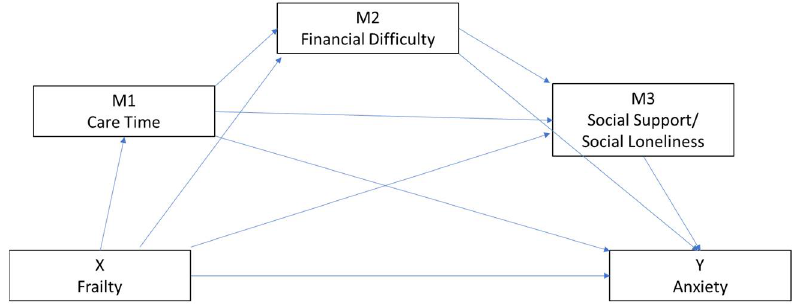
Figure 1. Hypothesized serial moderation model.